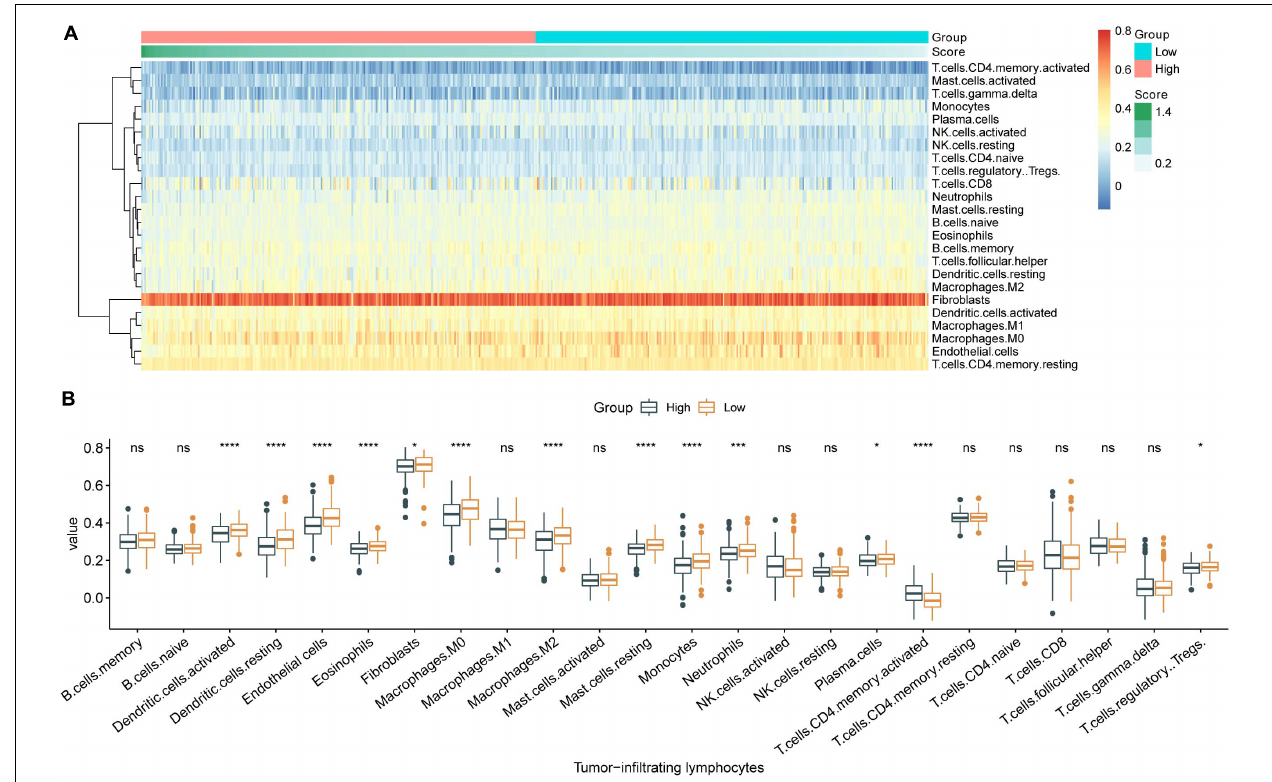
FIGURE 4 | The m6A-related gene set variation score (m6A-GSVS) and the levels of tumor-infiltrating lymphocytes (TILs). (A) Heatmap of 24 types of TILs and the m6A-GSVS in each individual. (B) Comparison of relative abundances of 24 types of TILs between samples with high or low m6A-GSVS. * p < 0.05, ** p < 0.01, *** p < 0.001, and **** p <